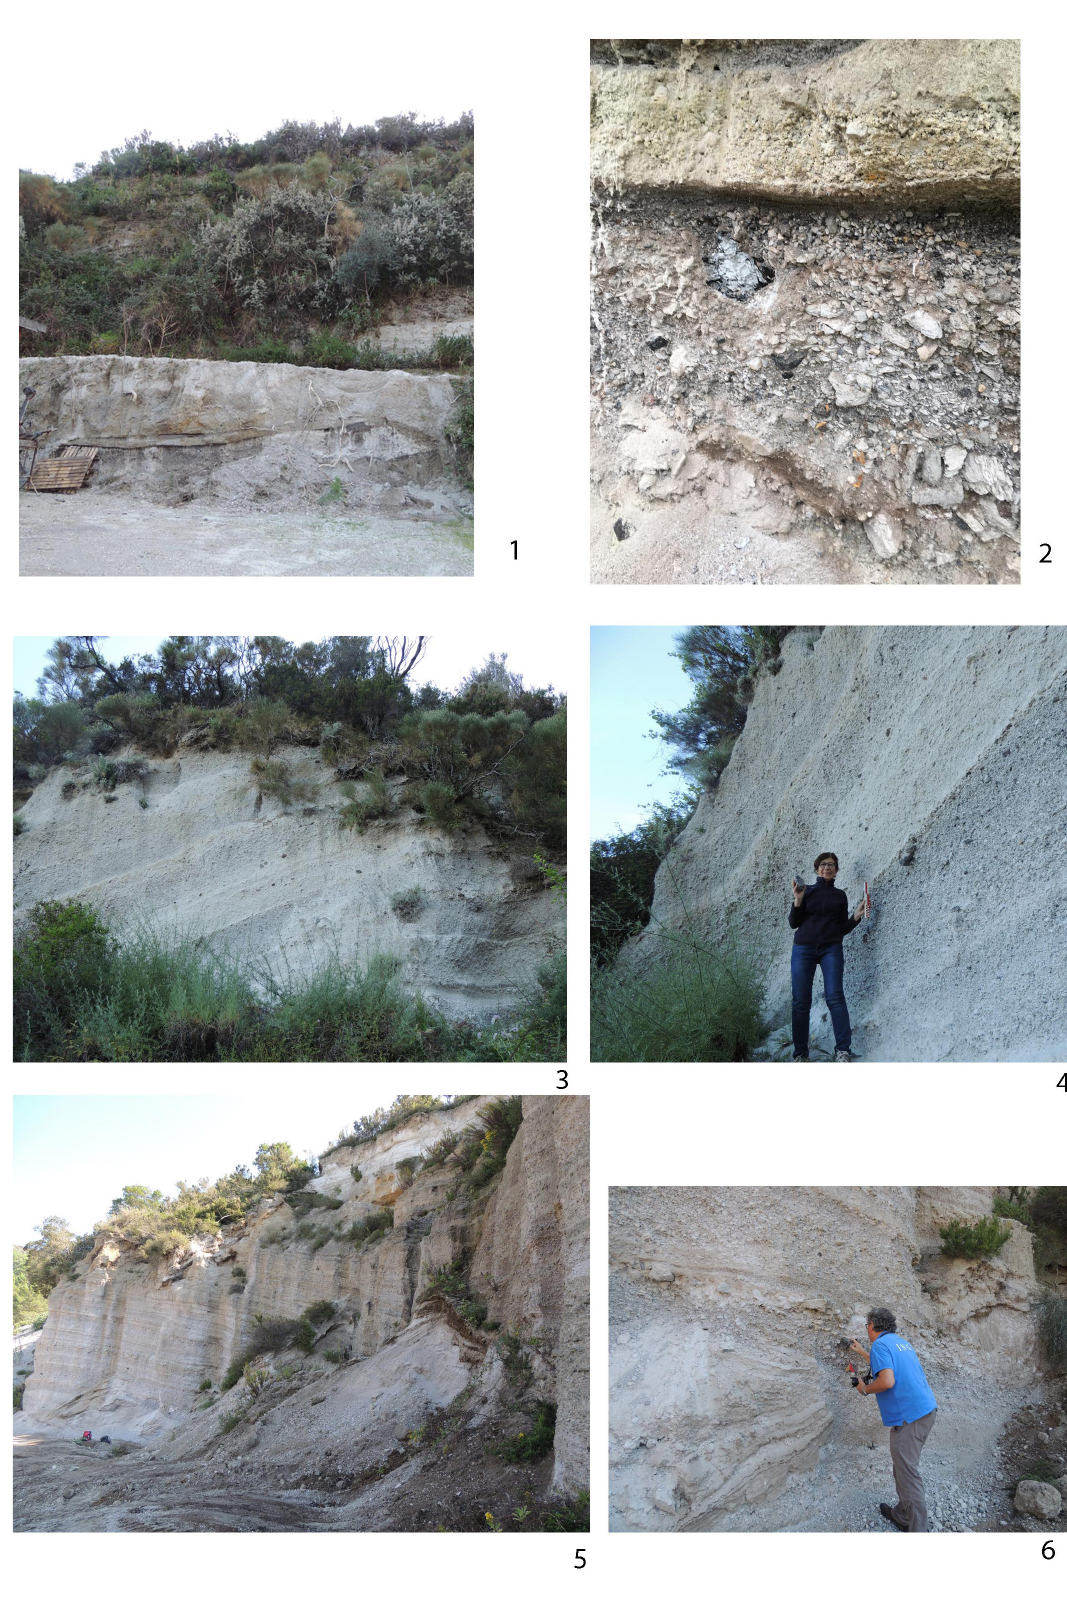
Figure 4: Lipari. Places of collected geological samples: 1–2) Canneto Dentro; 3–4) Vallone del Gabellotto; 5–6) Vallone Fiume